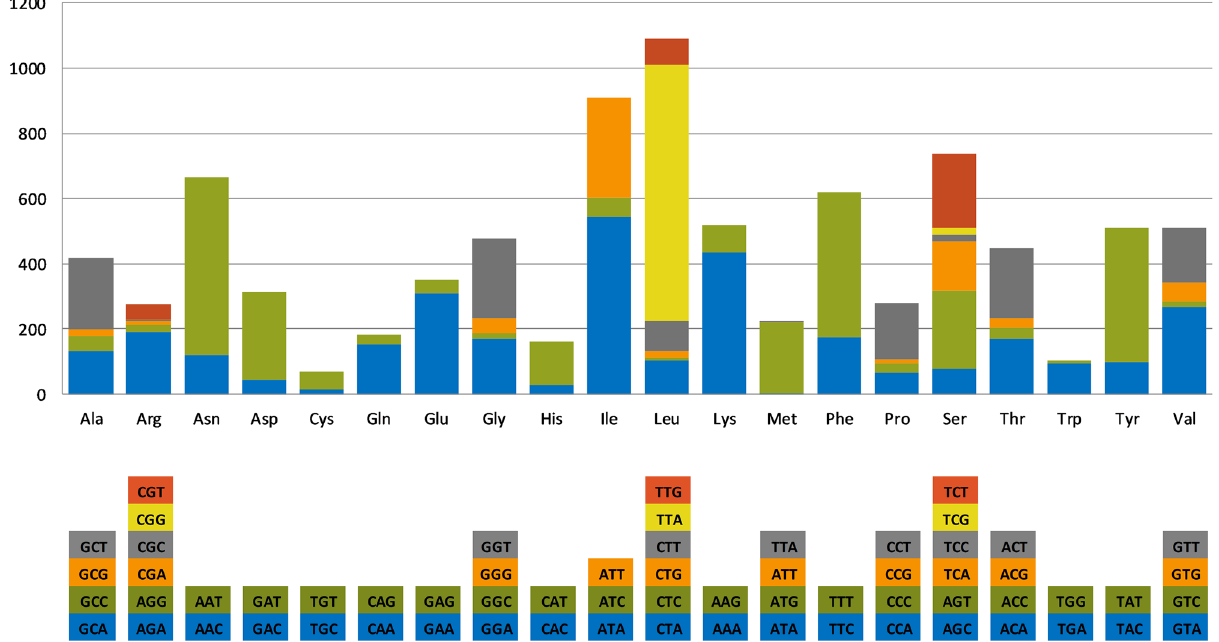
Figure 2. Codon usage in the mitochondrial genome of Ilyonectria destructans . Count of codon usage is plotted on the y-axis.